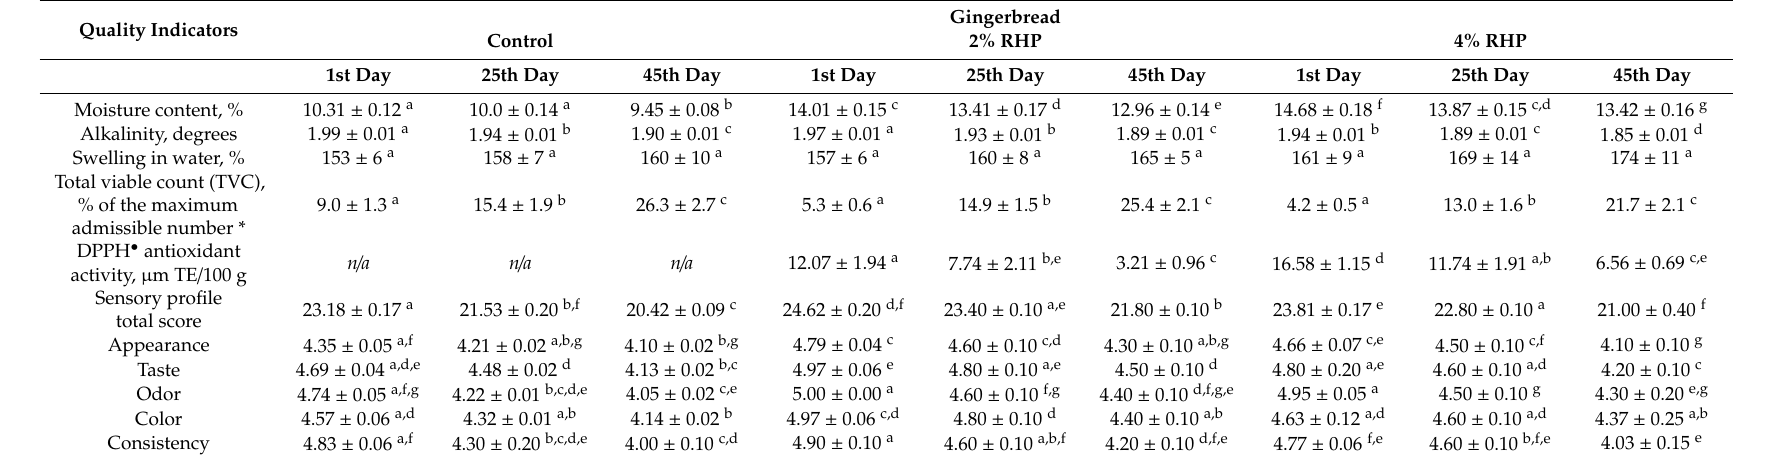
Table 4. Physicochemical and microbiological quality indicators, sensory profile, and antioxidant activity of gingerbread with added rose hip powder compared to the control (the results are presented as means ± standard